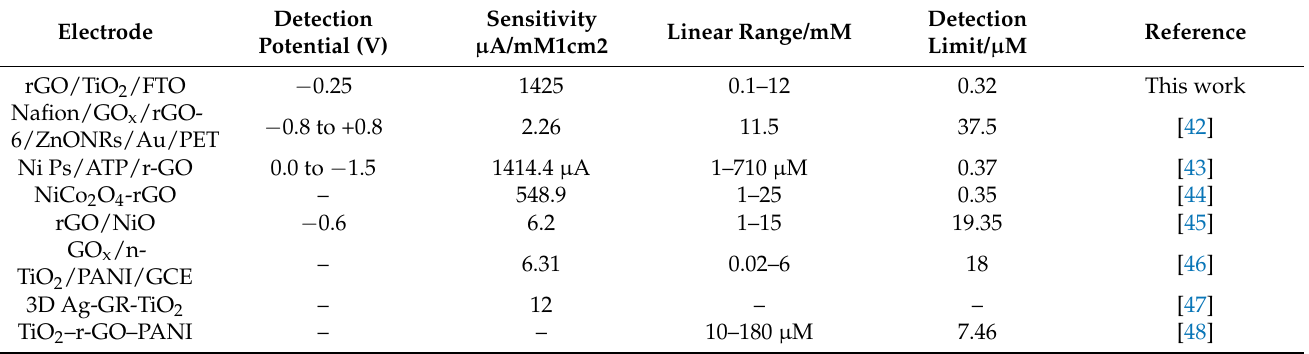
Figure 7. ( a ) Selectivity and ( b ) stability of rGO/TiO 2 /FTO sensor electrode. Table 2. Comparative analysis on sensitivity, detection limit, and linear range of rGO/TiO 2 /FTO glucose sensor.